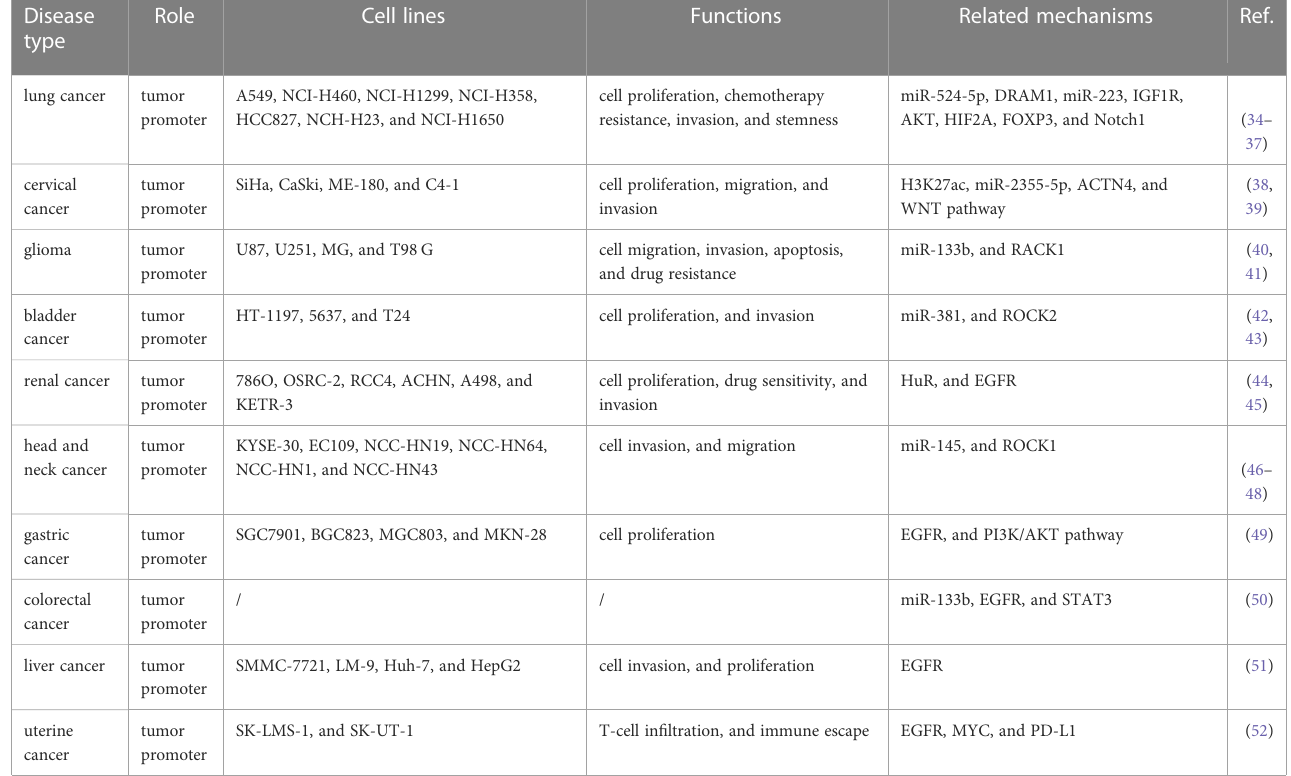
TABLE 2 Functions and mechanisms of EGFR-AS1 in